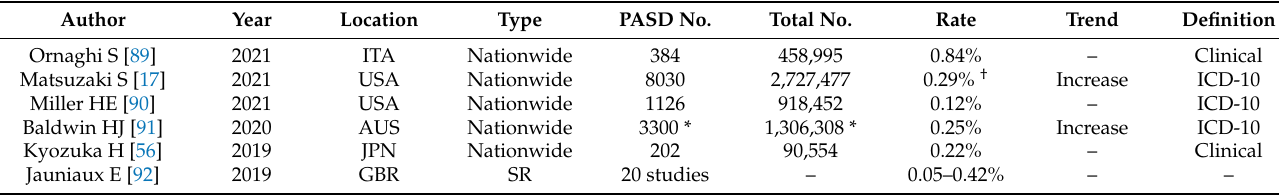
Table 1. The prevalence and trends of